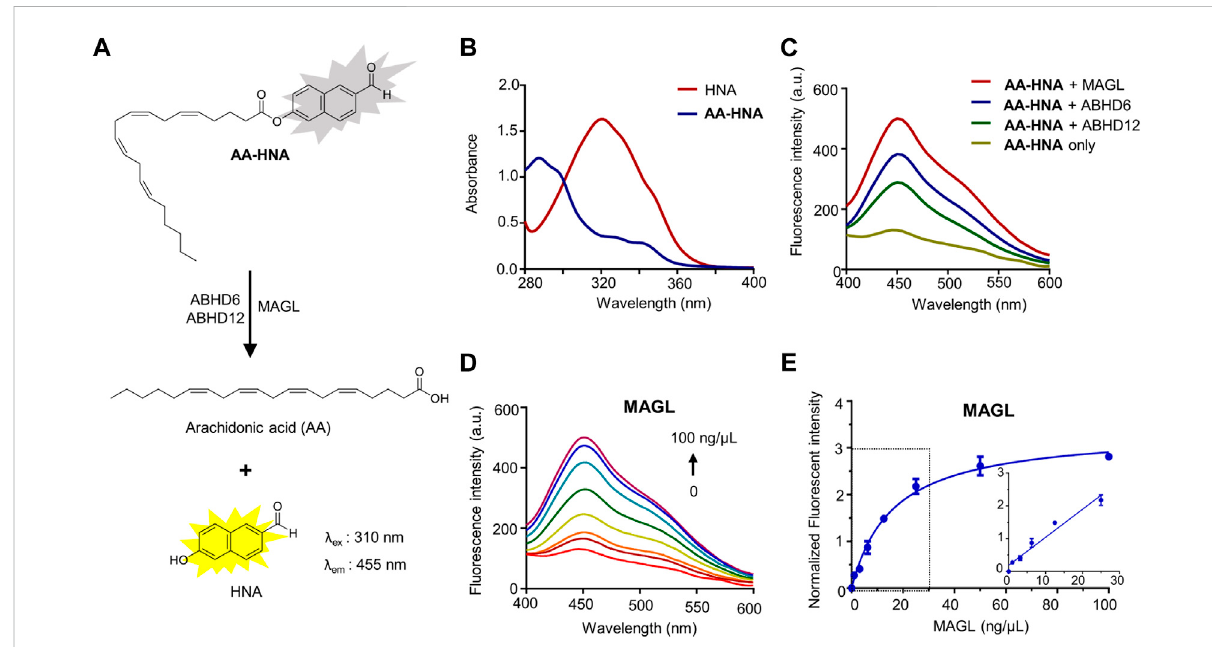
FIGURE 1 Fluorescenceturn-onresponsesof AA-HNA on2-AGhydrolases(MAGL,ABHD6,andABHD12). (A) Proposedmechanismof AA-HNA catalyzed by2-AG hydrolases (MAGL,ABHD6,andABHD12). (B) Absorbancespectraof AA-HNA andHNA. (C) Fluorescencespectra responseof AA-HNA after incubation (30 min) with MAGL, ABHD6, or ABHD12. (D) Concentration-dependent fl uorescence spectra response at the emission of 455 nm